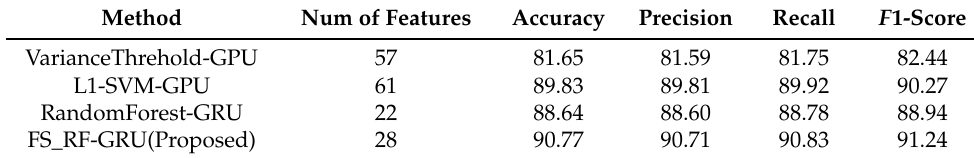
Table 4. Results on the sample